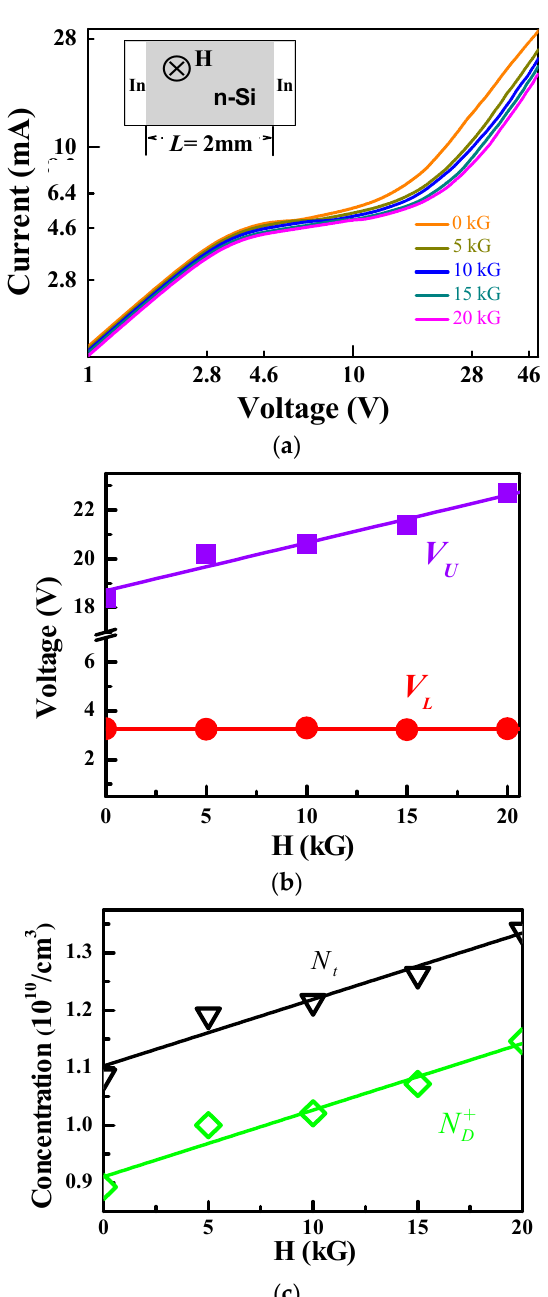
Figure 5. Magnetic field dependence of two critical voltages. ( a ) I–V curves of device 0129-1# with L = 2 mm under different magnetic fields measured at room temperature. Red and purple dash lines represent laws of Ohmic and MG, respectively. Insert, magnetic field applied perpendicularly to the sample surface and the current. ( b ) Magnetic field dependence of V L and V U . ( c ) Magnetic field dependence of N D + and N t . In ( b , c ), solid lines are the linear fitting guided by eyes to illustrate the magnetic field dependence of those parameters experimentally.